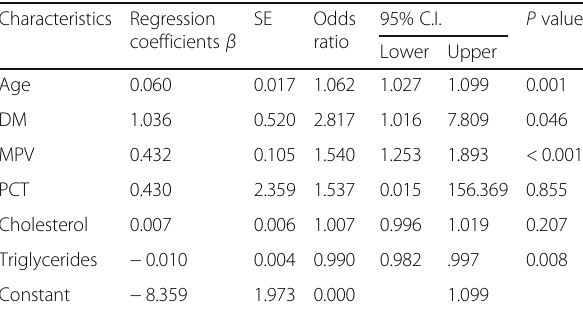
Table 3 Predictors of stroke outcome by using multivariate logistic regression analysis for determining the role of MPV and PCT in predicting stroke